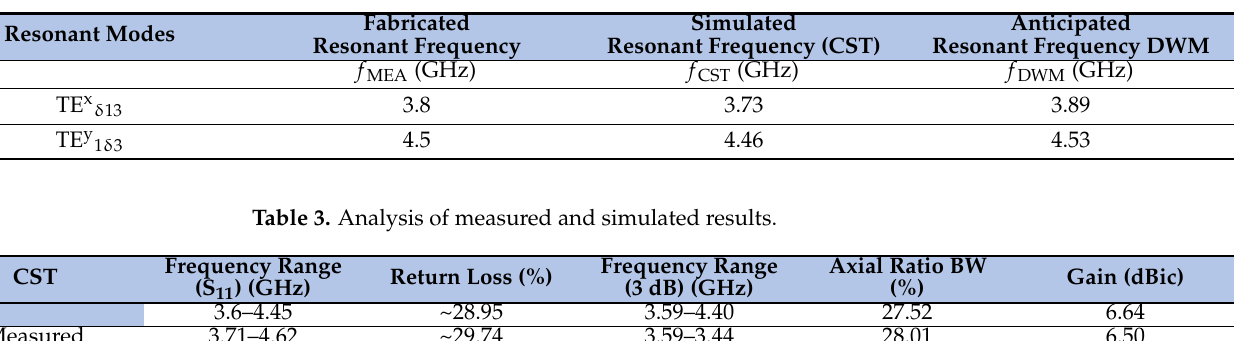
Table 2. Analysis of the measured, calculated, and projected DRA frequencies for TE x δ 13 and TE y 1 δ 3 modes.